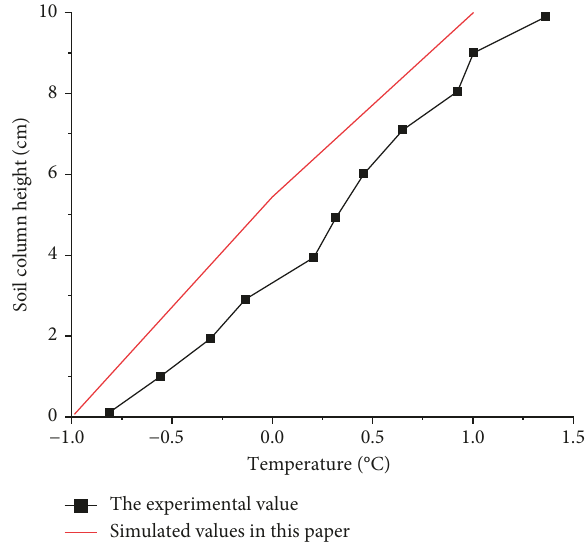
Figure 3: Temperature distribution in